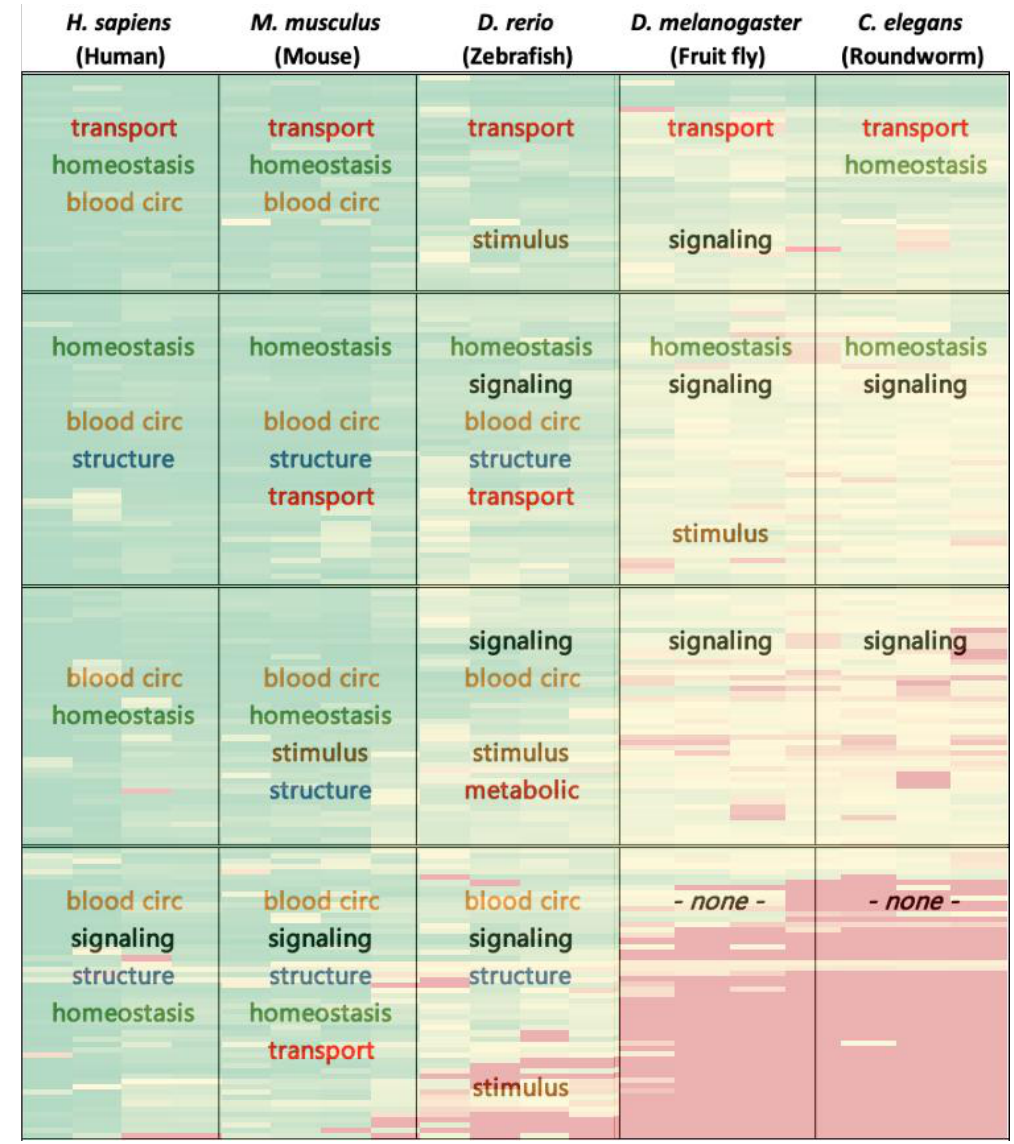
Figure 2. Demonstrates a summary of functional analysis results overlaid on heatmap of Figure 1. In each box, results pertain to the enriched biological processes for the respective genes-organisms of the cluster. For ease of interpretation, the colored text represents biological process families, reflecting their distribution throughout the map. For full functional analysis results please refer to Supplementary Table S1.